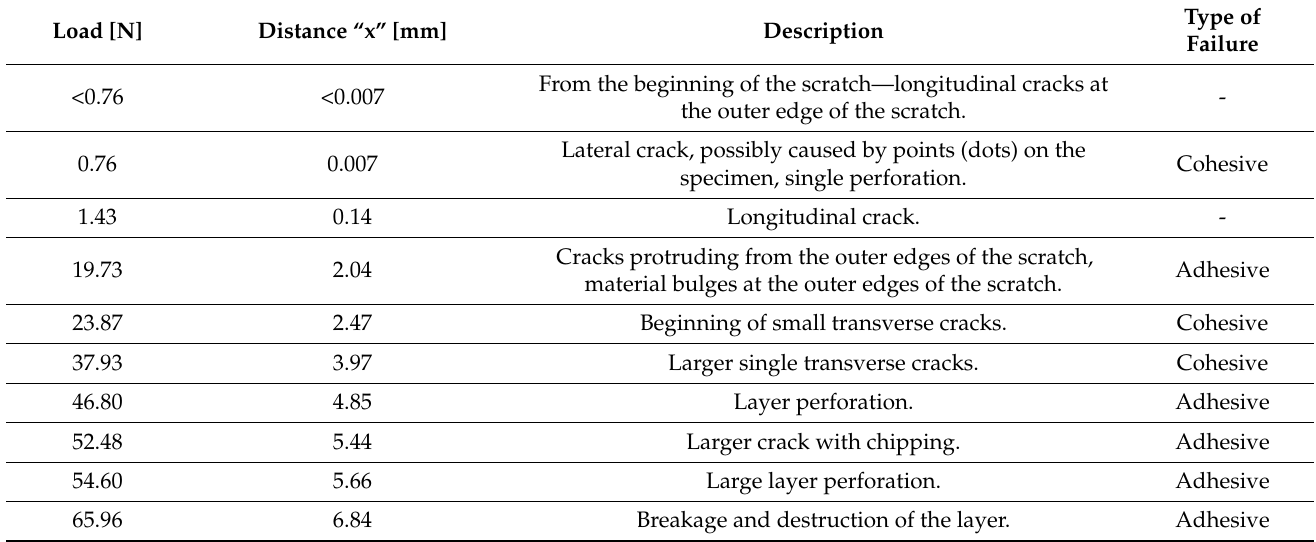
Figure 6. Images of scratches on the surfaces of layers: Ni-P/Si 3 N 4 ; ( A ) Ni-P/Si 3 N 4 (2 g/dm 3 ); ( B ) Ni-P/Si 3 N 4 (5 g/dm 3 ). The white arrows indicate the coating destruction point. However, detailed analyses of the results are presented in Tables 7 and 8. Changes in the topography are noticeable at low-pressure values (0.76 N and 1.73 N), propagating, according to the load, transversely to the head movement. Table 7. Description of the scratch test for Ni-P/Si 3 N 4 (2 g/dm 3 )